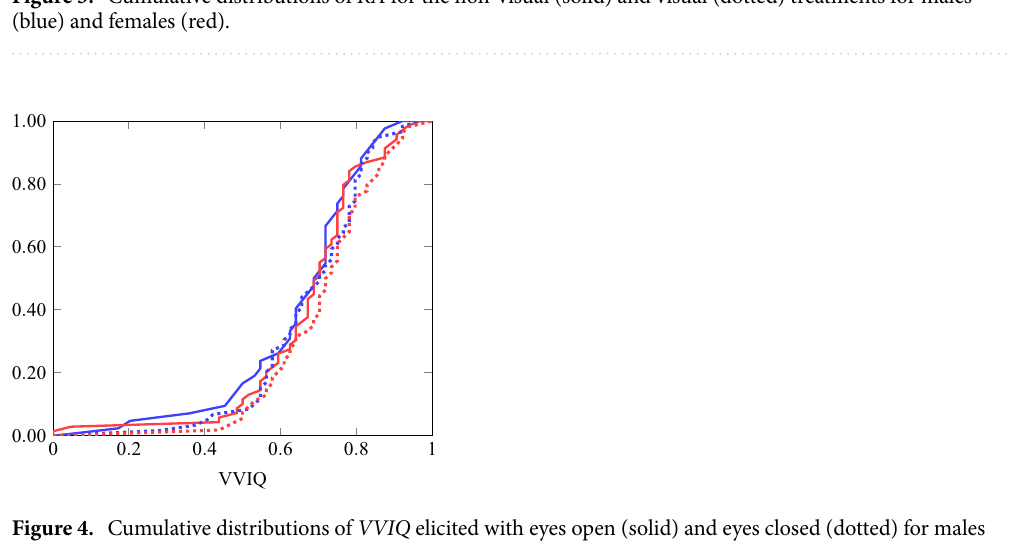
Figure 4. Cumulative distributions of VVIQ elicited with eyes open (solid) and eyes closed (dotted) for males (blue) and females